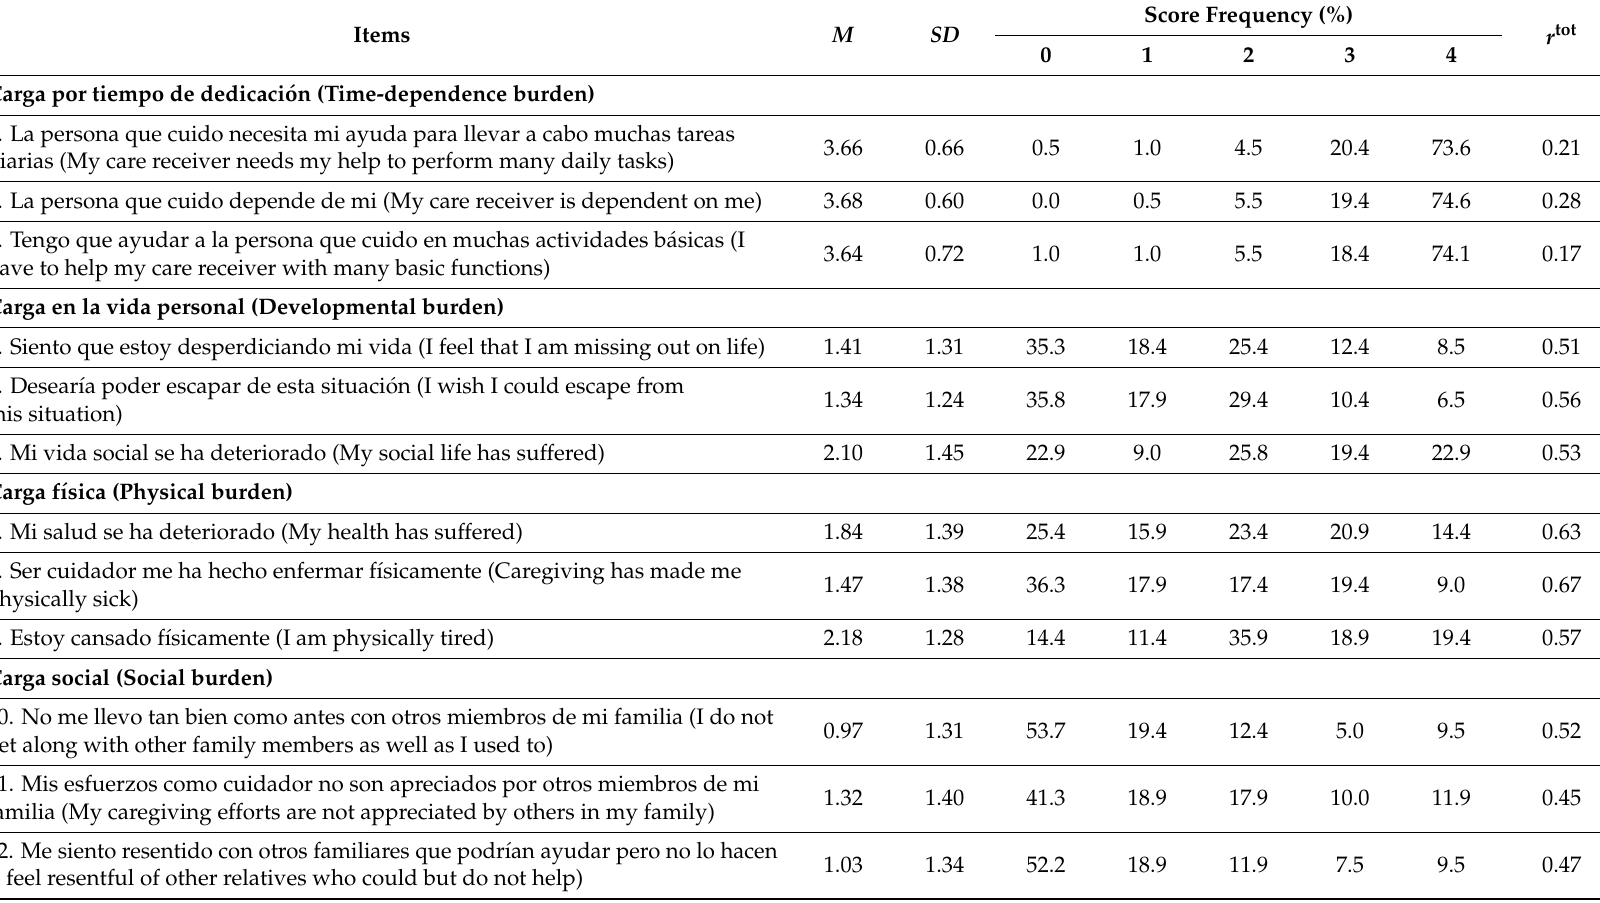
Table 5. Means, standard deviations, score frequency and corrected item-total correlation ( r tot ) for each item of the 15-item CBI. Items M SD